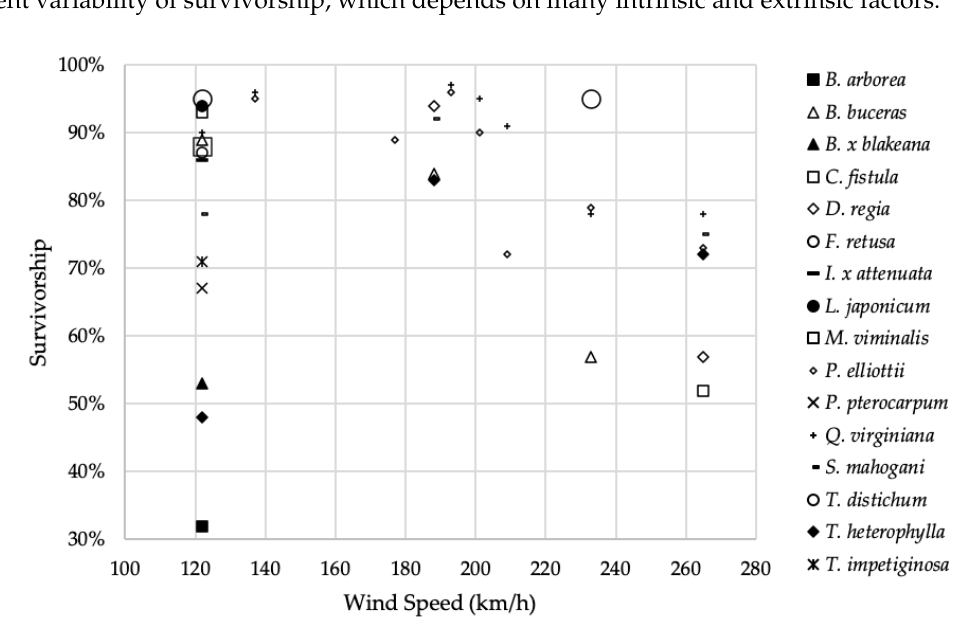
Figure 3. Scatter plot of survivorship of open-grown individuals vs. wind speed for 16 species and eight hurricanes in Florida, USA. Data from the current study (15 species) align with 122 km/h (average sustained wind across six measurement points [30]); the remaining data come from [5,11,12]. Note that the axes do not intersect at zero. Complete binomials are in Table 1, except for Pinus elliottii Engelm.